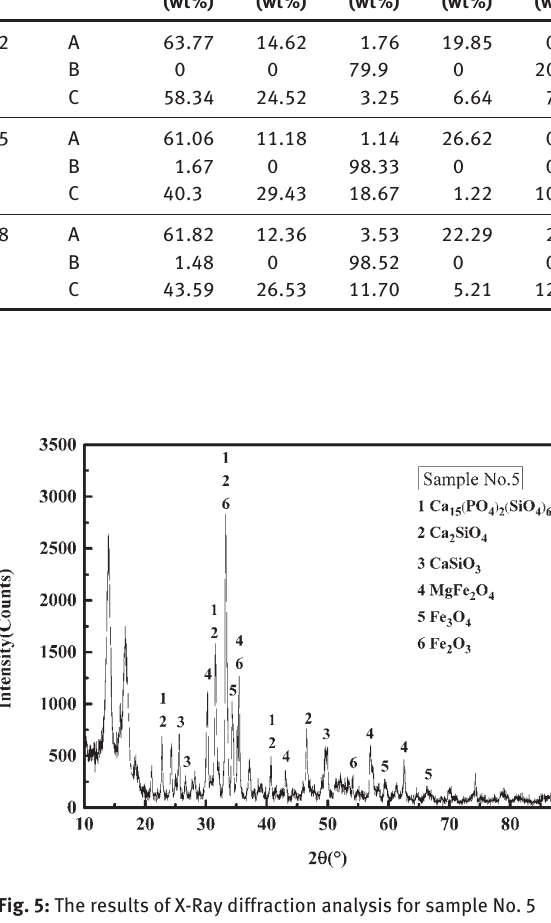
Fig. 5: The results of X-Ray diffraction analysis for sample No. 5